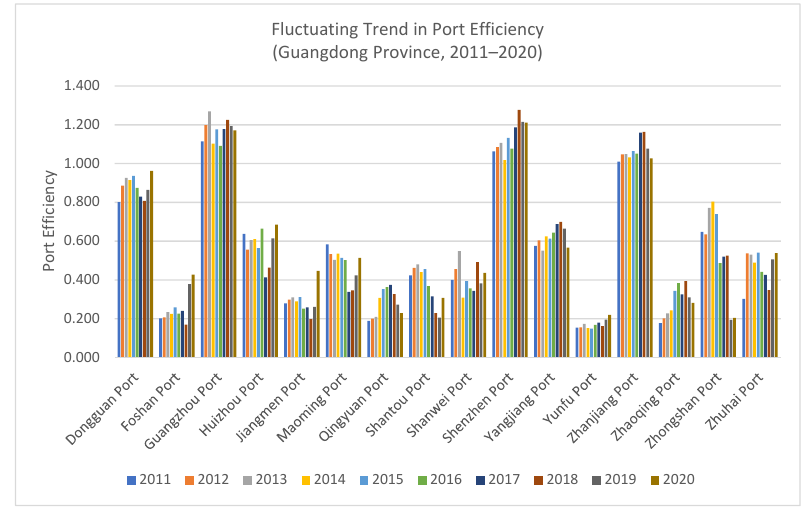
Figure 2. Port efficiency time series change from 2011 to 2020. Future Transp. 2022 , 2, FOR PEER REVIEW